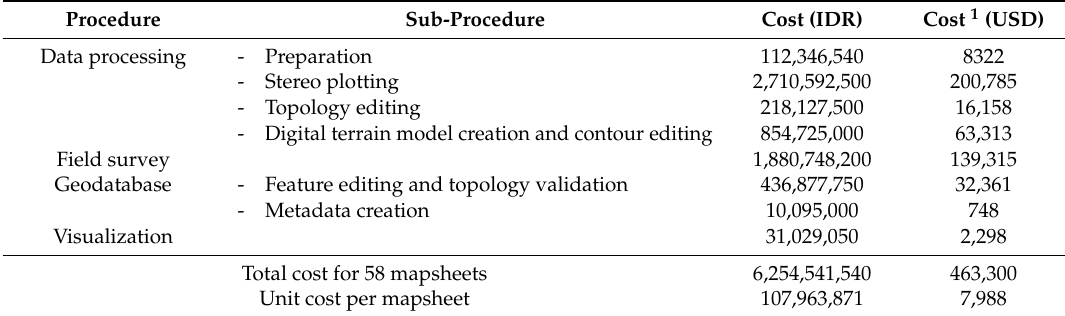
Table 4. Cost estimation of 1:5000 scale topographic mapping of Cibinong District using the aerial photo